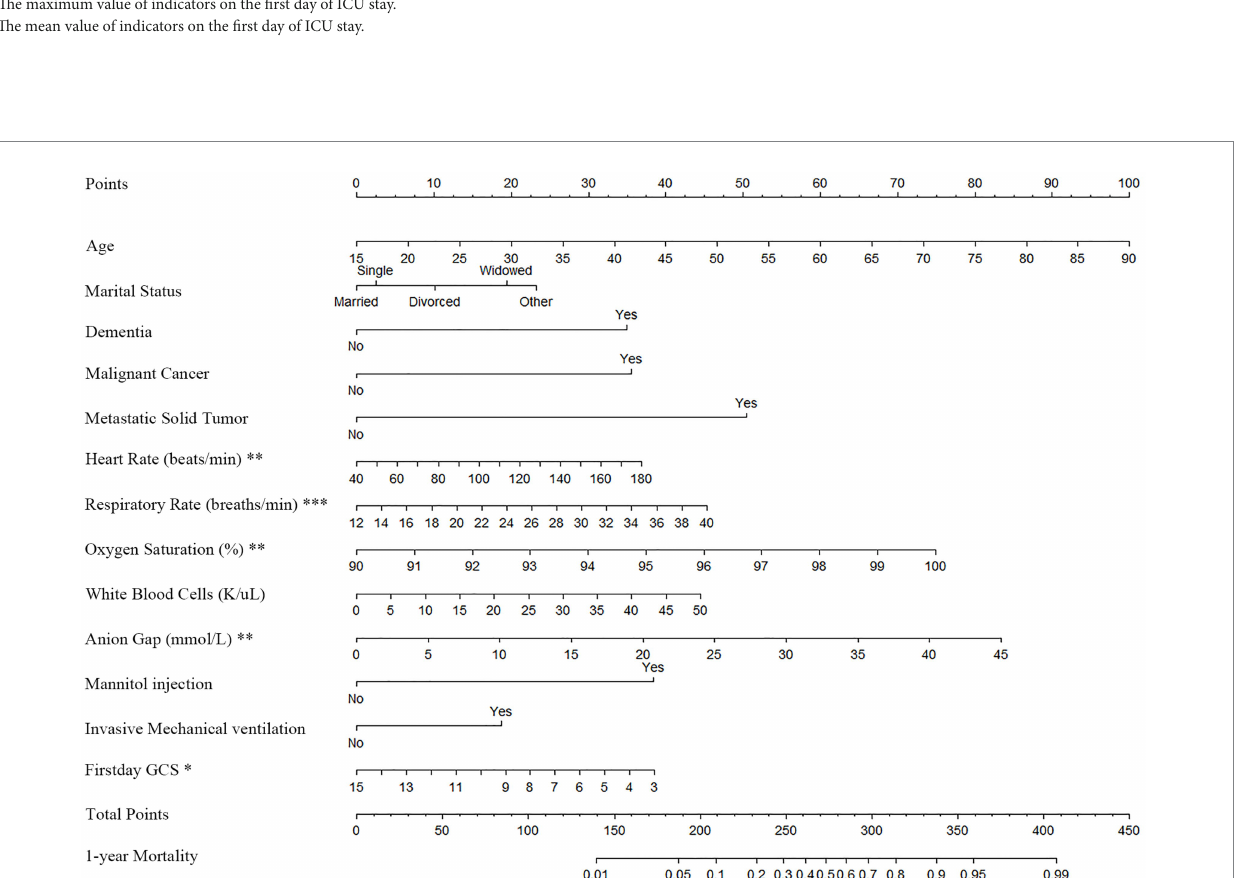
FIGURE 3 Nomogram for predicting 1-year mortality among ischemic stroke patients. A specific patient can be scored according to the items in the nomogram, and the 1-year mortality is assessed according to the total points obtained.